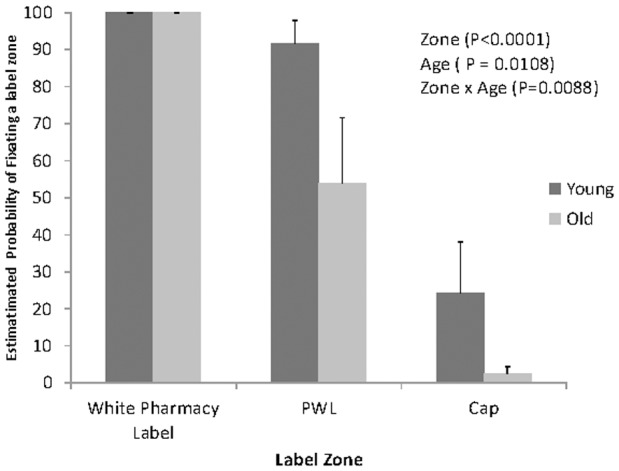
Least Square Mean Estimates (across subjects) of percentage of the probability of fixation by zone and age group.Error bars represent the between subjects standard error.